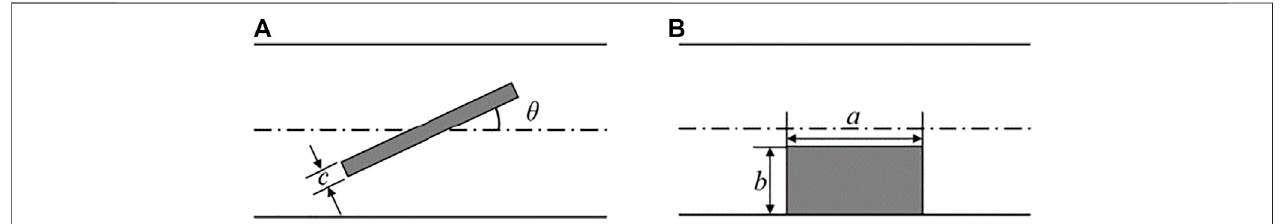
FIGURE 2 | Schematic diagram of inlet guide vanes: (A) side view; (B) radial view.